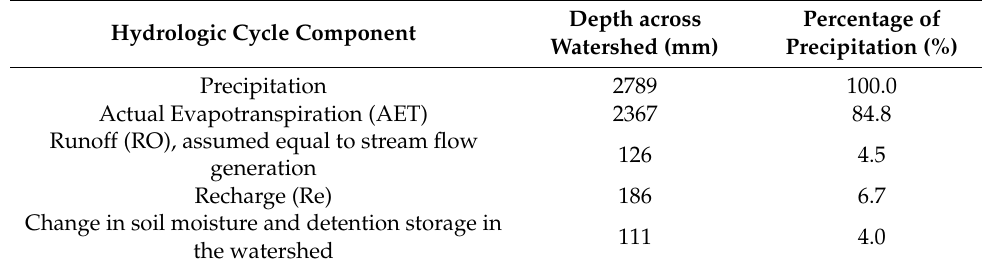
Table A3. Water budget from calibration simulation,